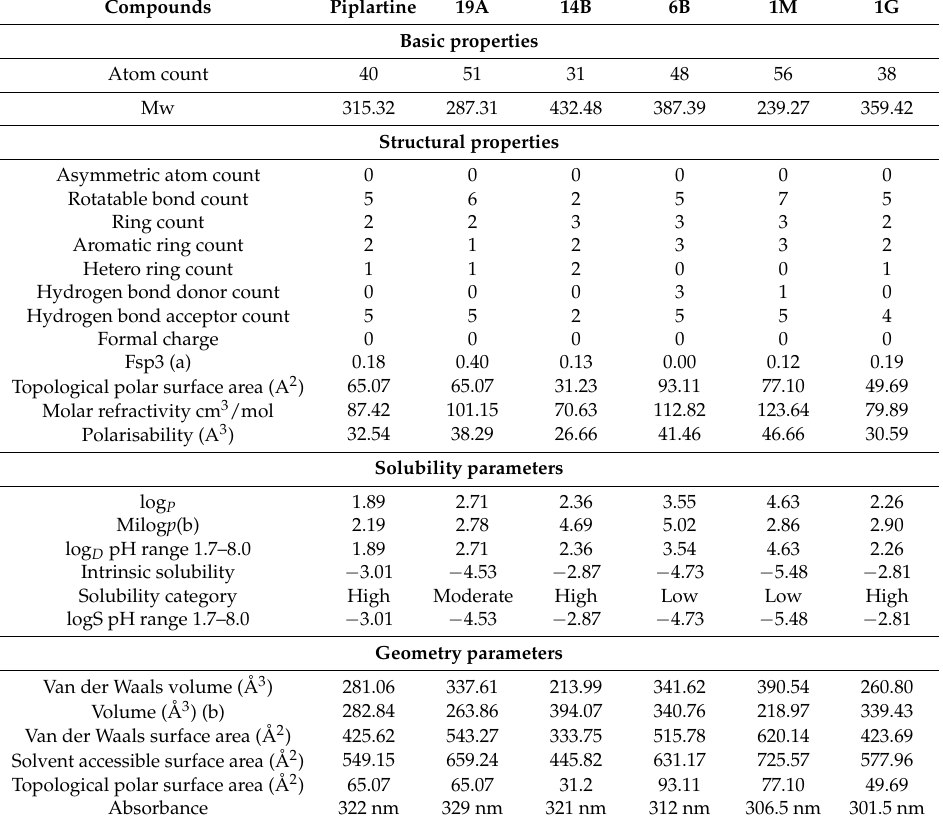
Table 1. Basic, geometric, structural, and solubility parameters of the parent and analogue compounds.